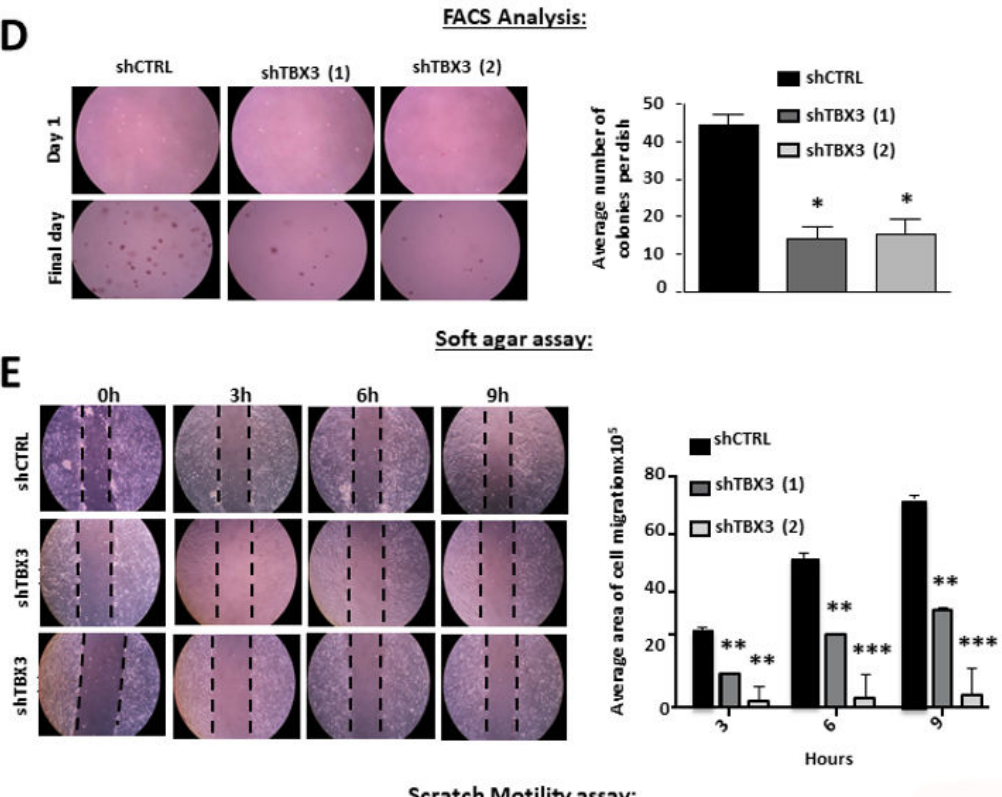
Figure 4. TBX3 knock-down inhibits cell proliferation, induces apoptosis and blocks anchorage- independent growth and migration of ERMS cells. ( A , B ) Growth curve analysis of RD shCTRL and shTBX3 cell lines were performed in media supplemented with either ( A ) 10% fetal bovine serum (FBS) or ( B ) low serum conditions (2% FBS). ( C ) Fluorescence-assisted cell sorting of indicated cell lines. Percentages of cells in each phase of the cell cycle are indicated. ( D ) RD shCTRL and shTBX3 cell lines were suspended in soft-agar medium slurry and allowed to proliferate for 30 days. Whole dishes were stained with p-iodinitrotetrazolium, and representative images are shown (200X magnification). (Left) Representative images are shown (200 × magnification). (Right) Quantification of at least 40 fields of view from three independent experiments. ( E ) Cell motility assays were performed to measure the migration of RD shCTRL and shTBX3 cells. A linear wound was made on confluent cells and distance migrated was measured at 3, 6 and 9 h. The values in the graphs represent the mean of at least four independent experiments ± SEM (* p < 0.05, ** p < 0.001, *** p <